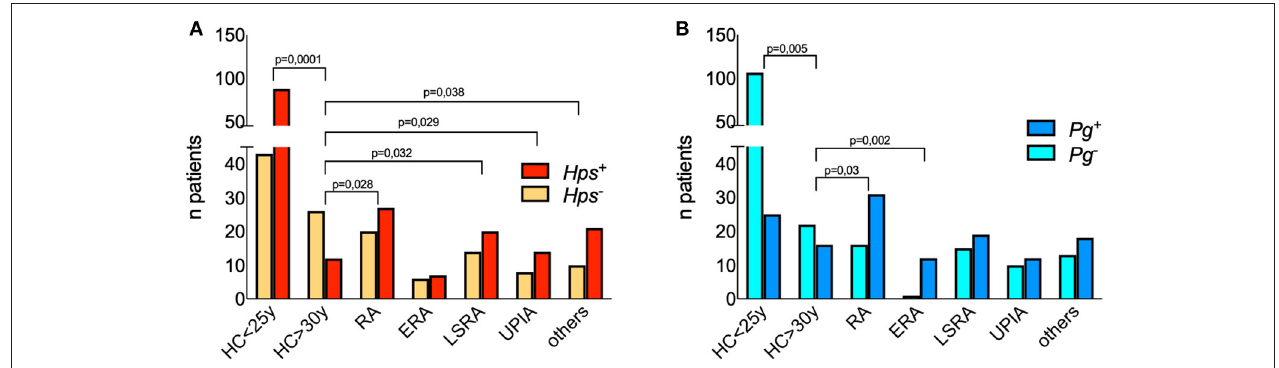
FIGURE 1 | Detection of 16S DNA for Hps and Pg in the crevicular fluid of patients and controls. Each bar represents the numbers of patients and healthy controls positive for Pg (A) and Hps (B) . Differences between proportions have been calculated with two-sided Fisher’s Exact test and significant p values are displayed among groups. Hps DNA was detected by polymerase chain reaction (PCR) amplifying species-specific sequences on the 16S rRNA gene proved useful for detection of Hps in clinical samples 21. The following primer’s pairs were used in a nested-PCR. Outer primers: Hps16S-forw 5 ′ AGAGTTTGATCATGGCTCAGA3 ′ and Hps